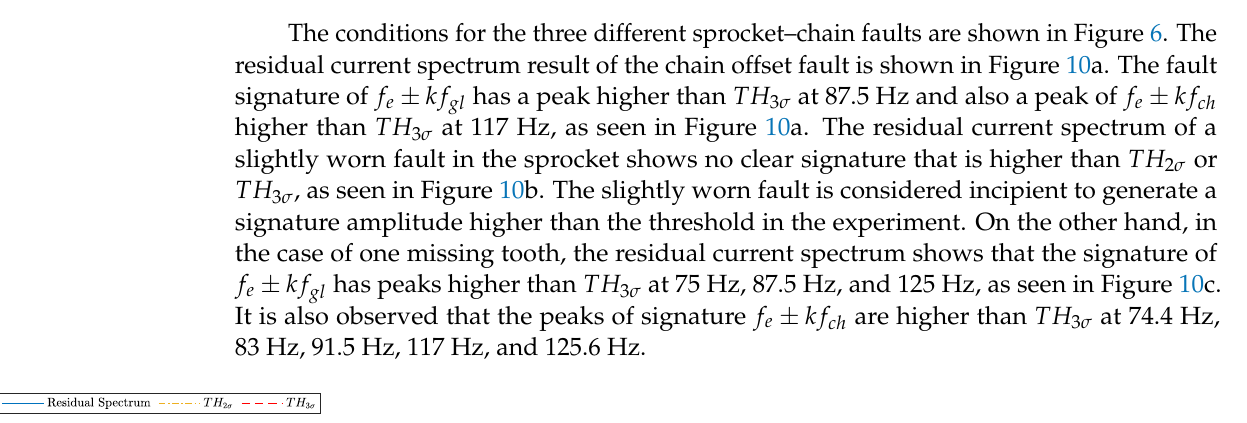
Figure 9. Gear-to-gear fault parameter clustering: ( a ) slightly worn damage at a tooth of the driven gear; ( b ) severely worn damage along a tooth of the driven gear; ( c ) no lubricant at both the driving and driven gear.